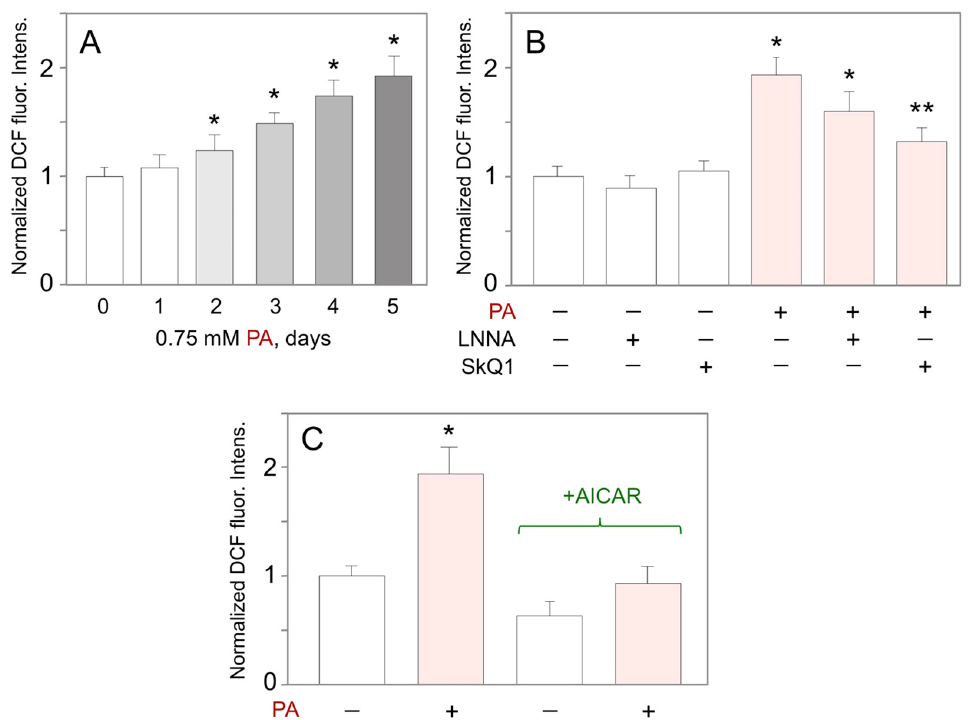
Figure 5. Effects of palmitate and AICAR on ROS production by HUVEC. ( A ) Time-dependent changes in ROS production in response to 0.75 mM PA (* p < 0.05 vs. day 0, n = 3). ( B ) Inhibitory analysis of PA-induced ROS production measured at day 5 of cell treatment with 0.75 mM PA (* p < 0.05 vs. untreated control; ** p < 0.05 vs. PA-treated cells without inhibitors, n = 3). ( C ) Effects of AICAR (1 mM, 5 days) on ROS production in the presence or absence of 0.75 mM PA for 5 days (* p < 0.05 vs. untreated cells without AICAR, n = 3).